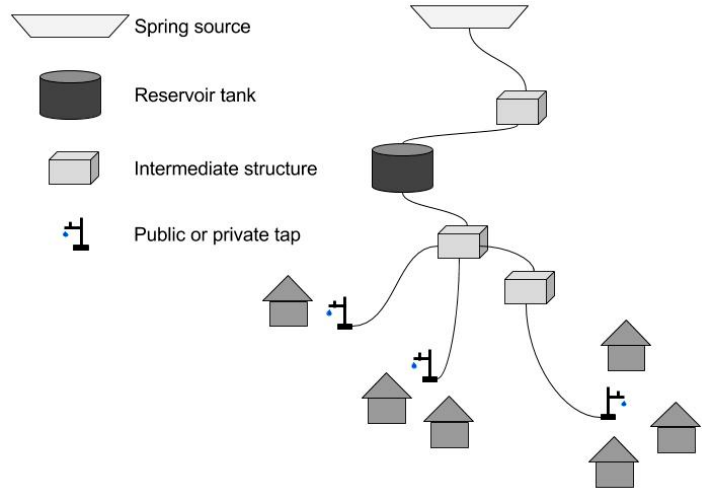
Figure 2. Sketch of a typical gravity-fed piped water scheme (or sub-scheme). Each scheme